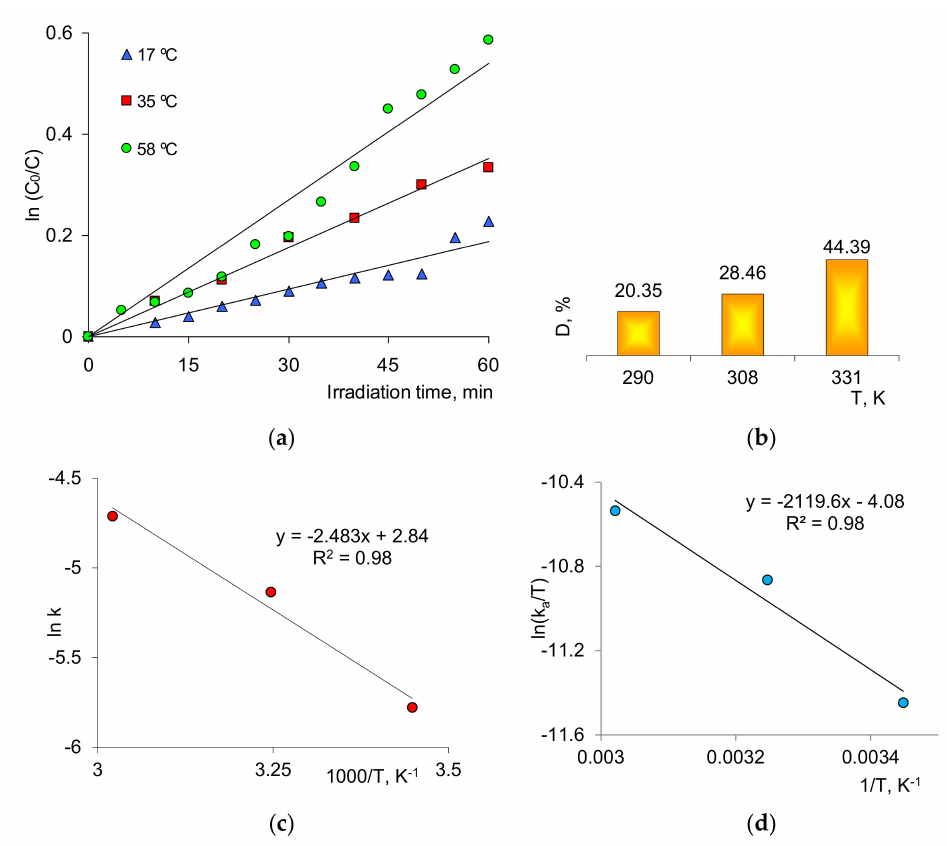
Figure 5. Efficiency of decomposition of MB (1.0 mg/L) in the presence of composite Ag/PET TeM at various temperatures ( a , b ). Arrhenius graph for determining Ea ( c ) and the Eyring plot for determining activation entropy ( ∆ S (cid:54) = ) and activation enthalpy ( ∆ H (cid:54) = ) ( d ).